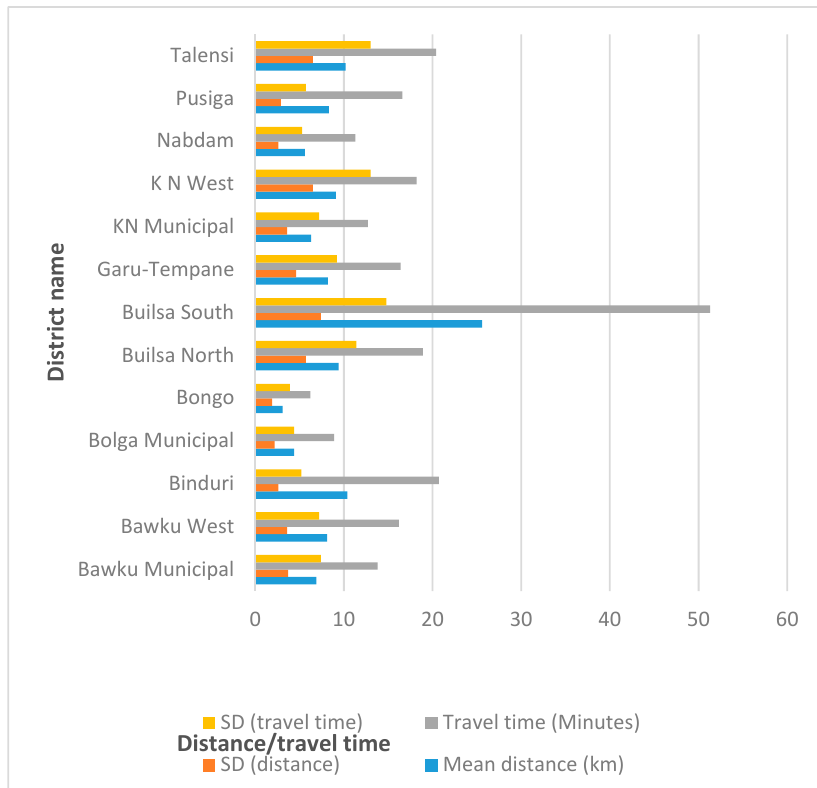
Figure 7. A bar chart depicting the mean distance and travel time from all 131 towns in the UER to a health facility providing blood group and rhesus type testing services per district in the region.